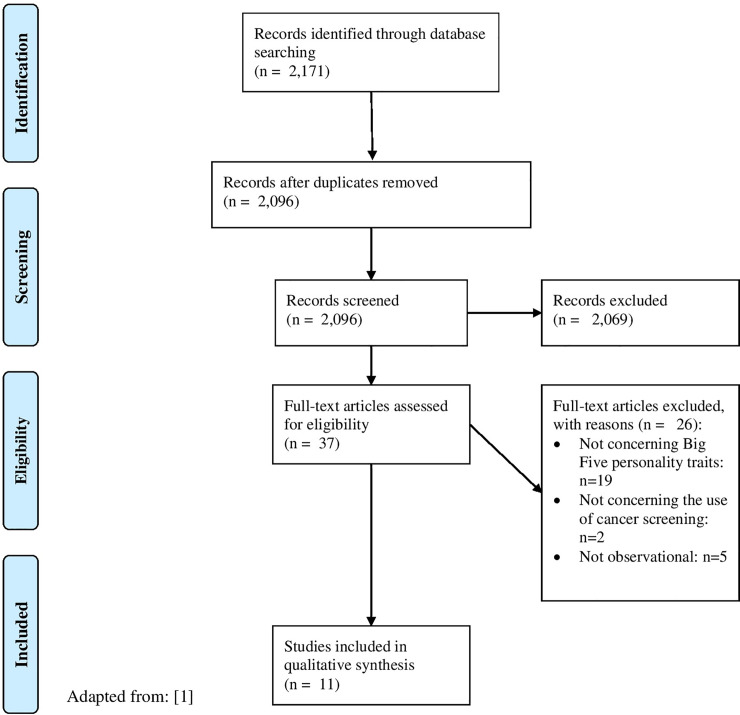
PRISMA flow diagram.